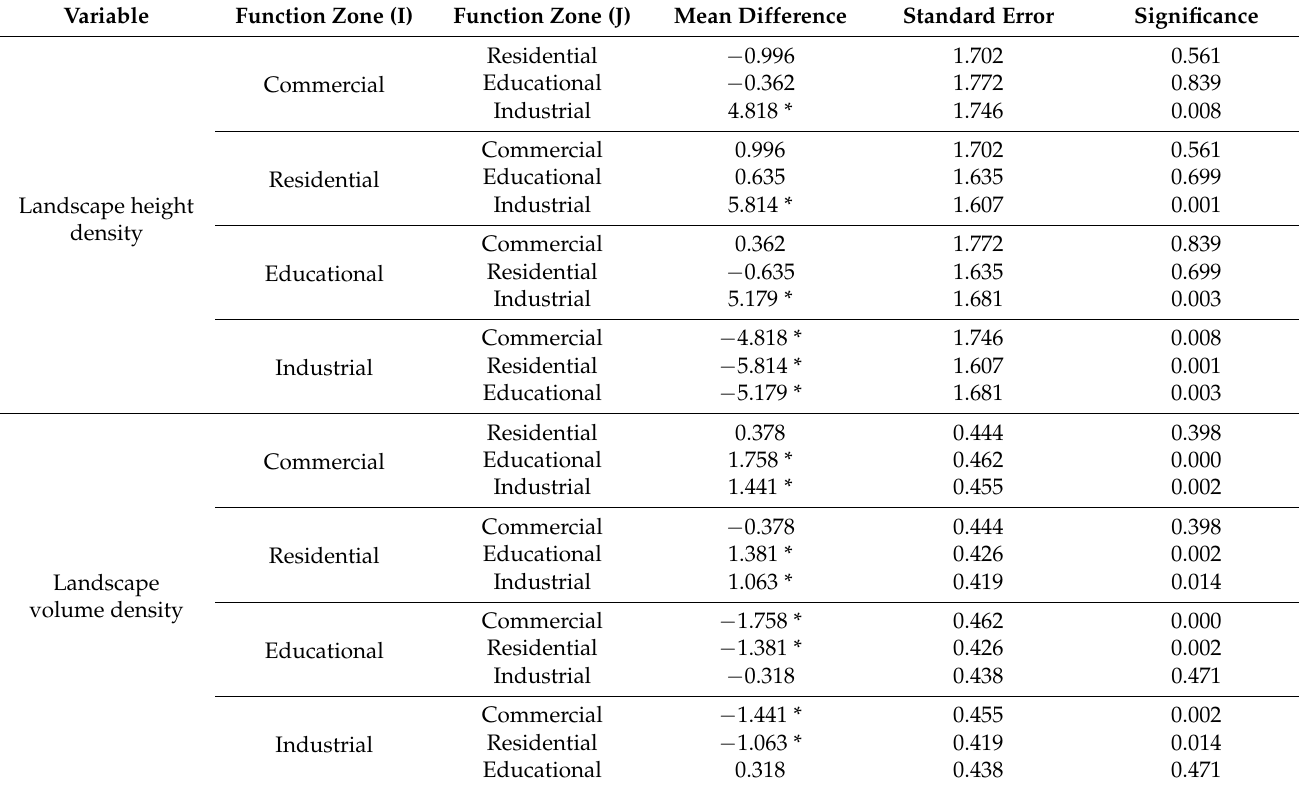
Table 6. Multiple comparison results of 3D landscape index in land-use function